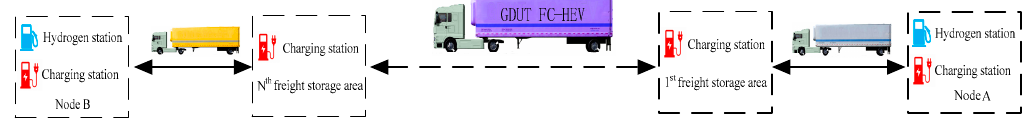
Figure 2. Transport mode connecting multiple destinations through one route.